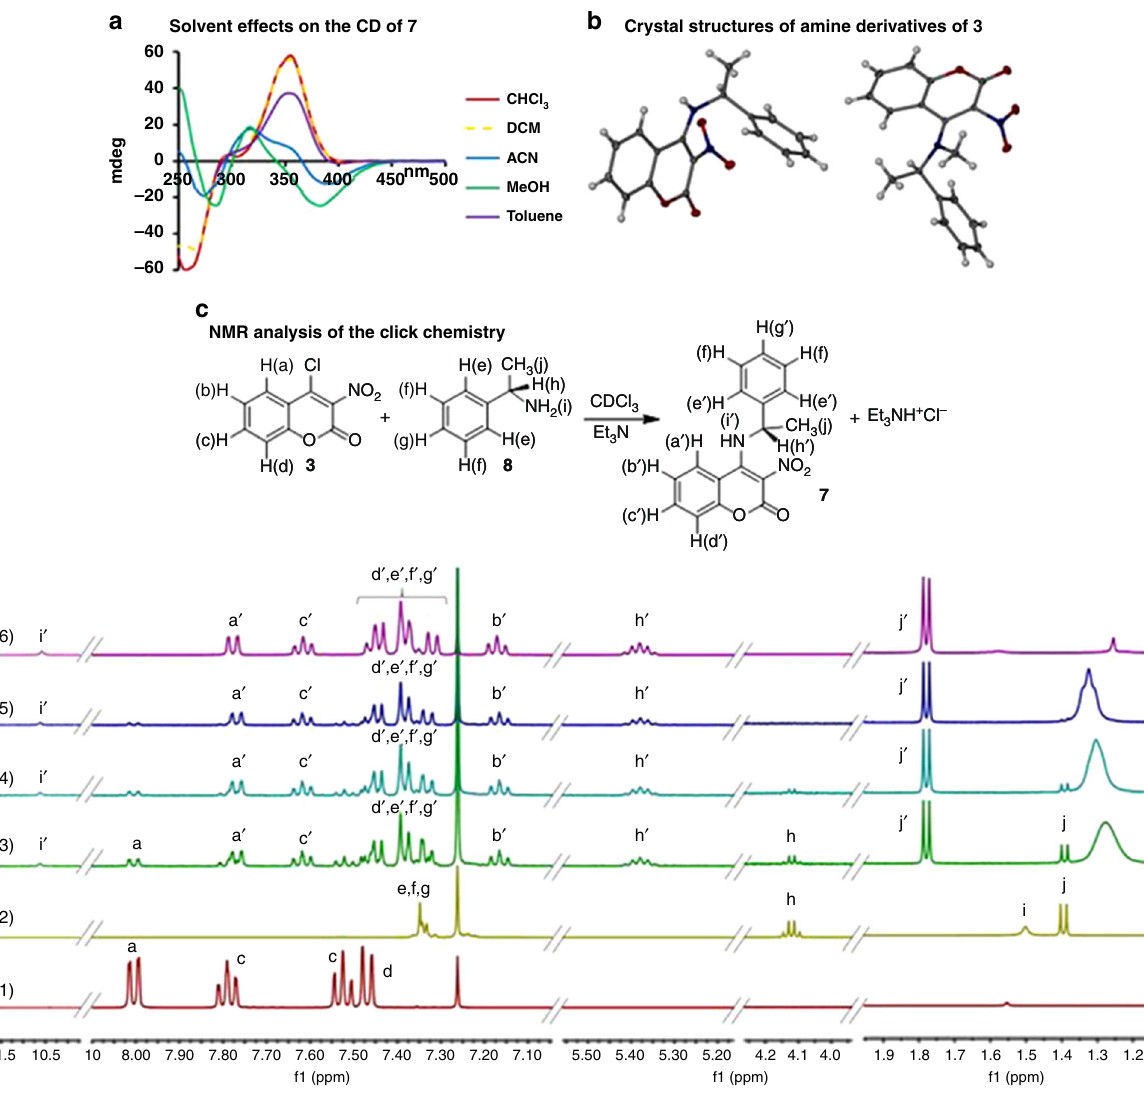
Fig. 2 Analysis of the sensing chemistry. a The CD spectra of 7 were obtained at 0.19 or 0.24mM when MeOH was used as solvent. b X-ray structures of chiral amine derivatives of 3 . c 1 H NMR analysis of the reaction between probe 3 and ( S )- 8 in the presence of Et 3 N (all 5.0 mM) in 0.8 mL of CDCl 3 . (1) Probe 3 ; (2) ( S )-1-phenylethylamine; (3) reaction mixture of ( S )-1-phenylethylamine, Et 3 N and probe 3 after 5 min; (4) reaction after 10 min; (5) after 15 min; and (6) isolated 3-nitro-4-((1-phenylethyl)amino)coumarin, 7 , for